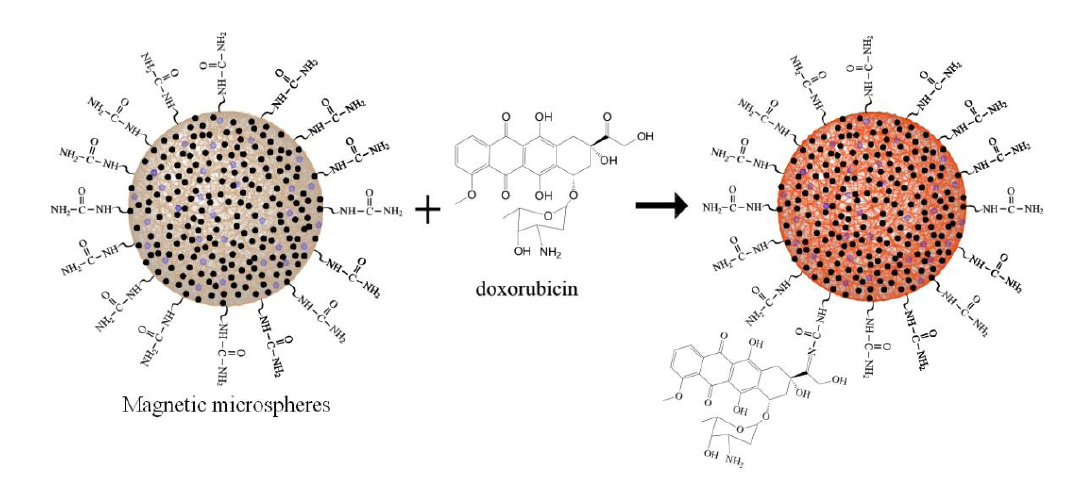
Figure 7. Scheme of doxorubicin bonding to gelatin glycylglycine terminals.